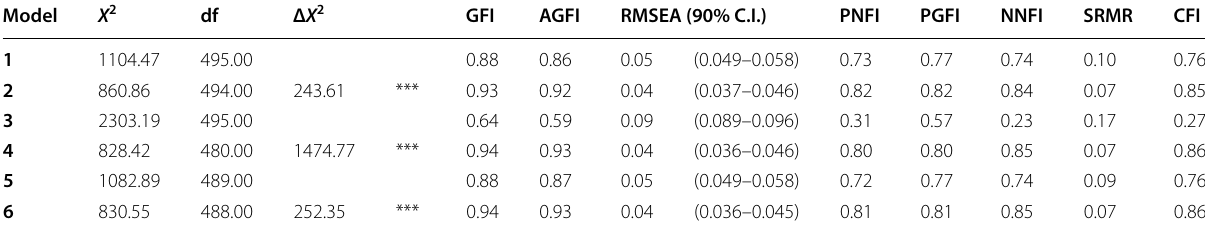
Table 3 Comparison of fit indices among the proposed